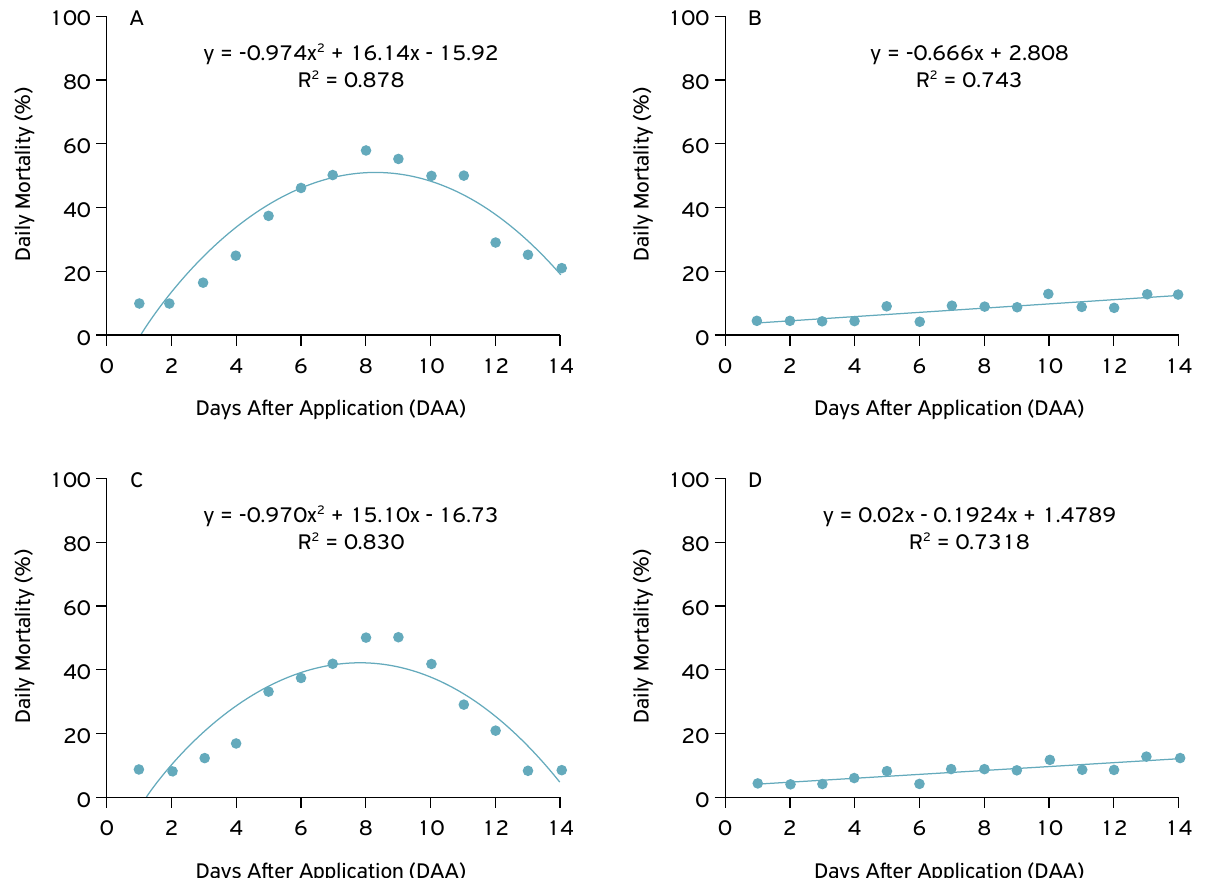
Figure3. (A) Daily mortality of N. viridula ; (B) N. viridula “Control treatment”; (C) D. melacanthus after application of the M. anisopliae (08RA isolate) in greenhouse; (D) Dichelops melacanthus (Control